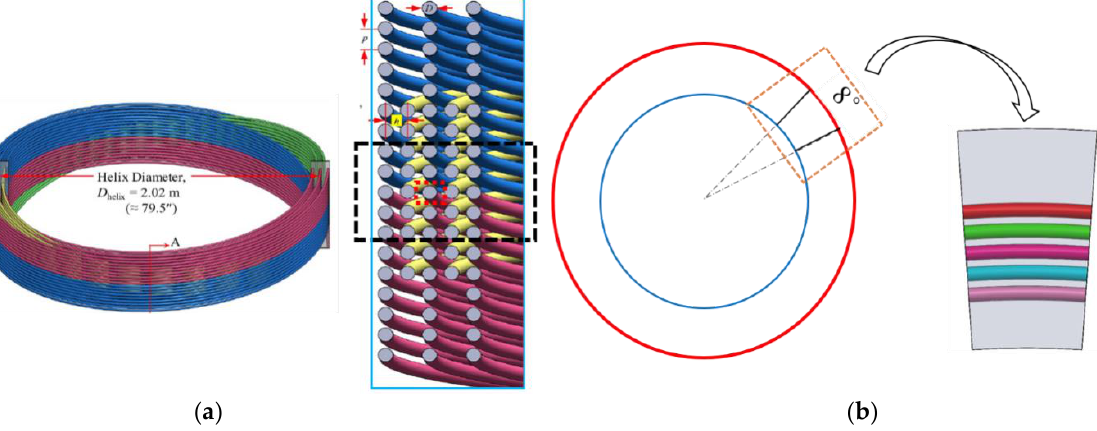
Figure 3. Helical tube array model and its simplified model: ( a ) Five-layer helical tube array model, ( b ) simplified to a 8 ° sector model [22]. ( b ) simplified to a 8 ◦ sector model